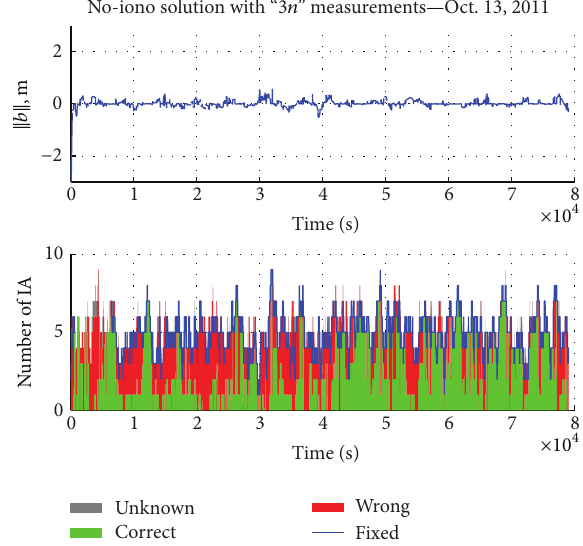
Figure 2: Baseline magnitude estimation error and L1 ambiguities estimation performance for set 3𝑛 .